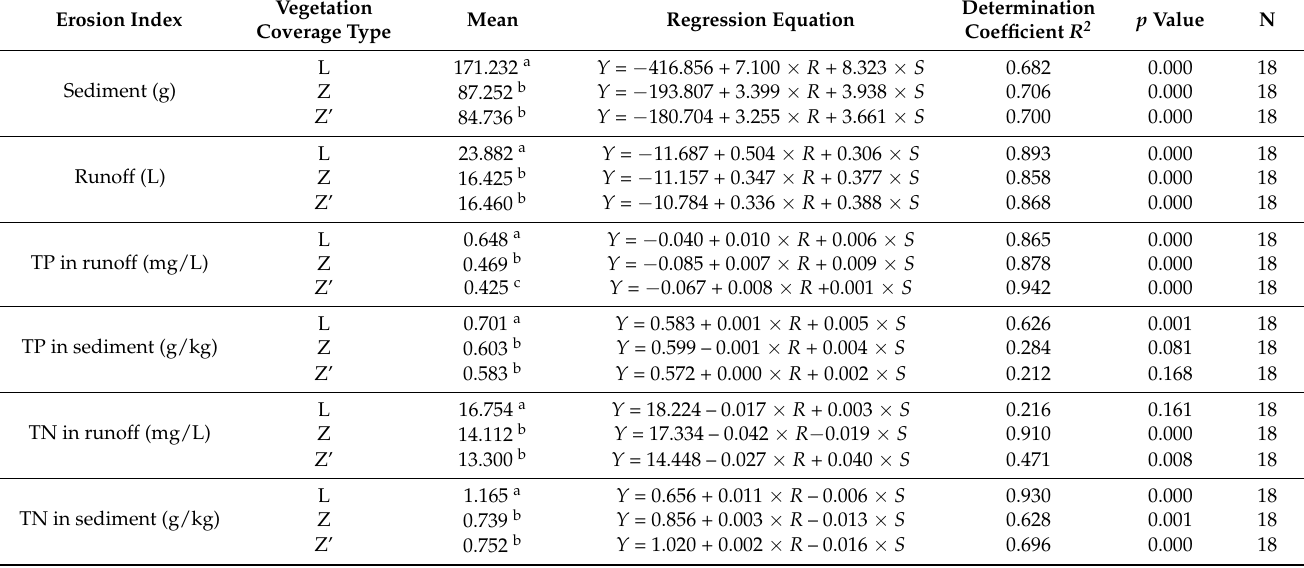
Table 4. Relationship between erosion indexes and rainfall intensity and slope under different vegetation coverage